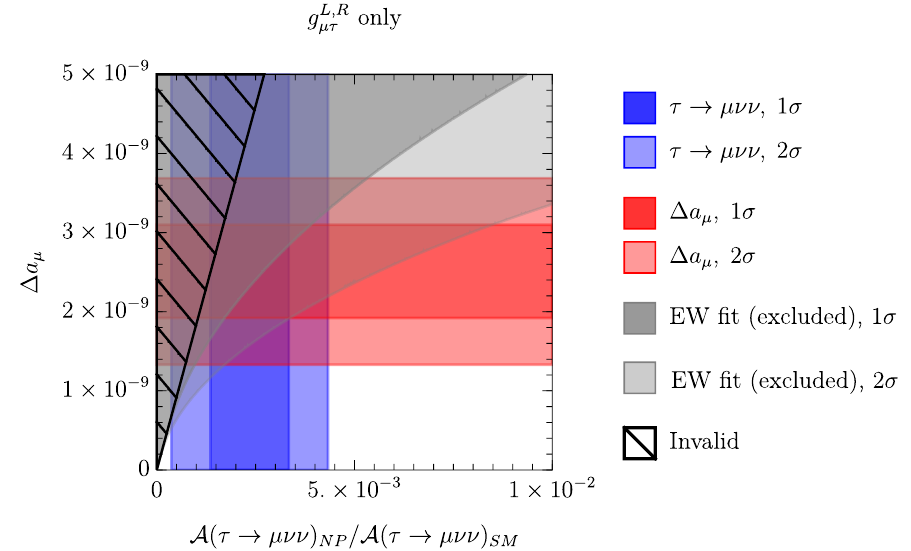
6 = 0 . µτ = 1 TeV. Note that Z 0